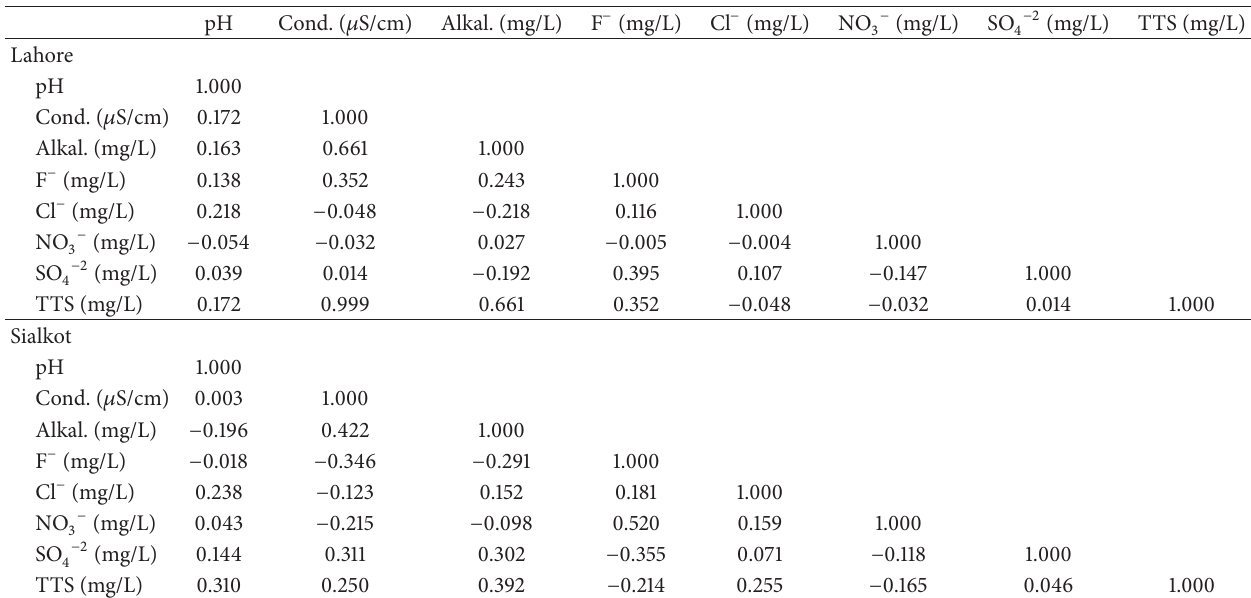
Table 2: Correlation coefficient matrix for the drinking water samples from Lahore and Sialkot.